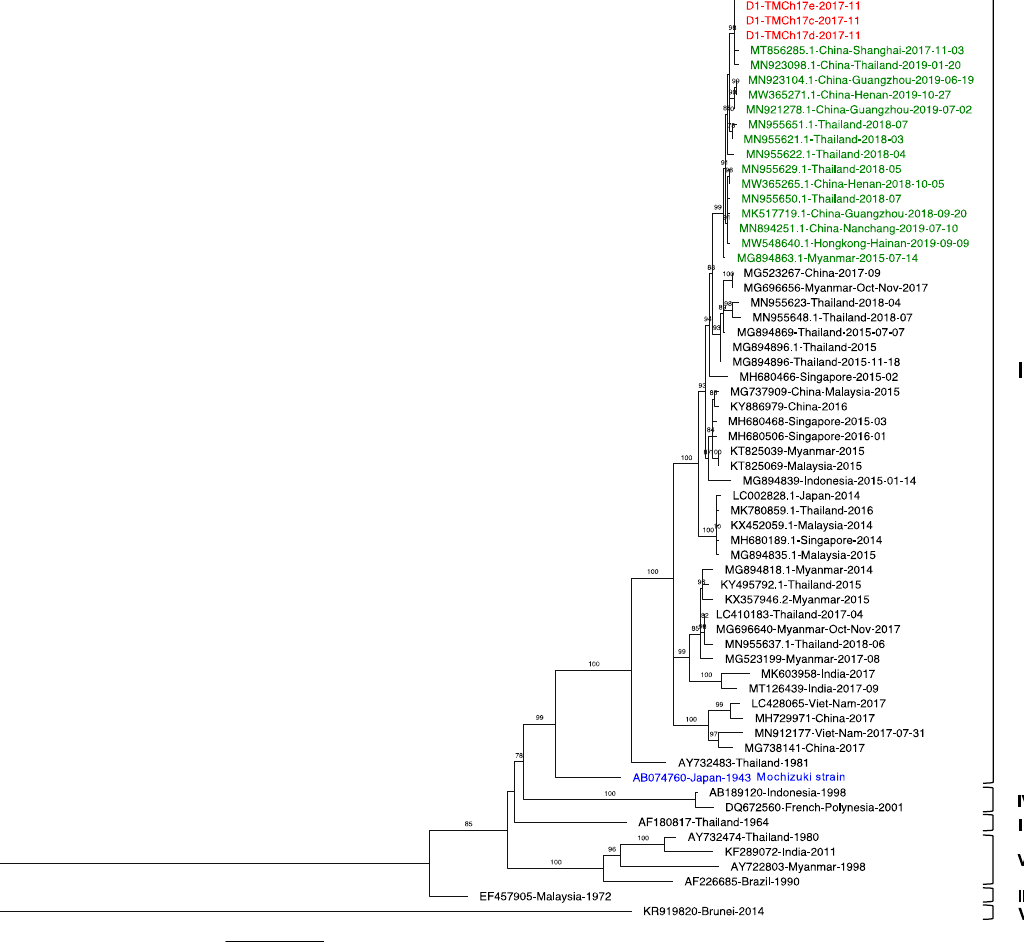
Figure 2. Maximum likelihood tree of DENV-1 based on the 1485 bp envelope region sequence. The tree was constructed using TIM2 + F + 4 with 1000 bootstrap replications. Bootstrap values >75 indicate a relationship to the adjacent branch. Sequences obtained in the present study, related sequences sharing nucleotide identity >99.60%, and the Mochizuki strain are indicated in red, green, and blue, respectively. DENV-1 genotypes are indicated by the brackets to the right.